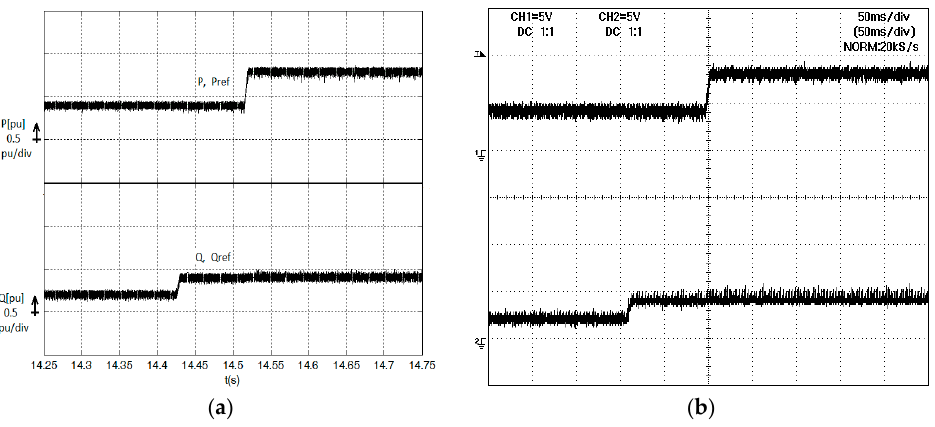
Figure 7. Active and reactive series power response for P and Q steps (first Δ Q Ref = +0.2 pu and after Δ P Ref = +0.4 pu). ( a ) Simulation results; ( b ) Experimental results (Ch1 = Ch2 = 0.5 pu/div).